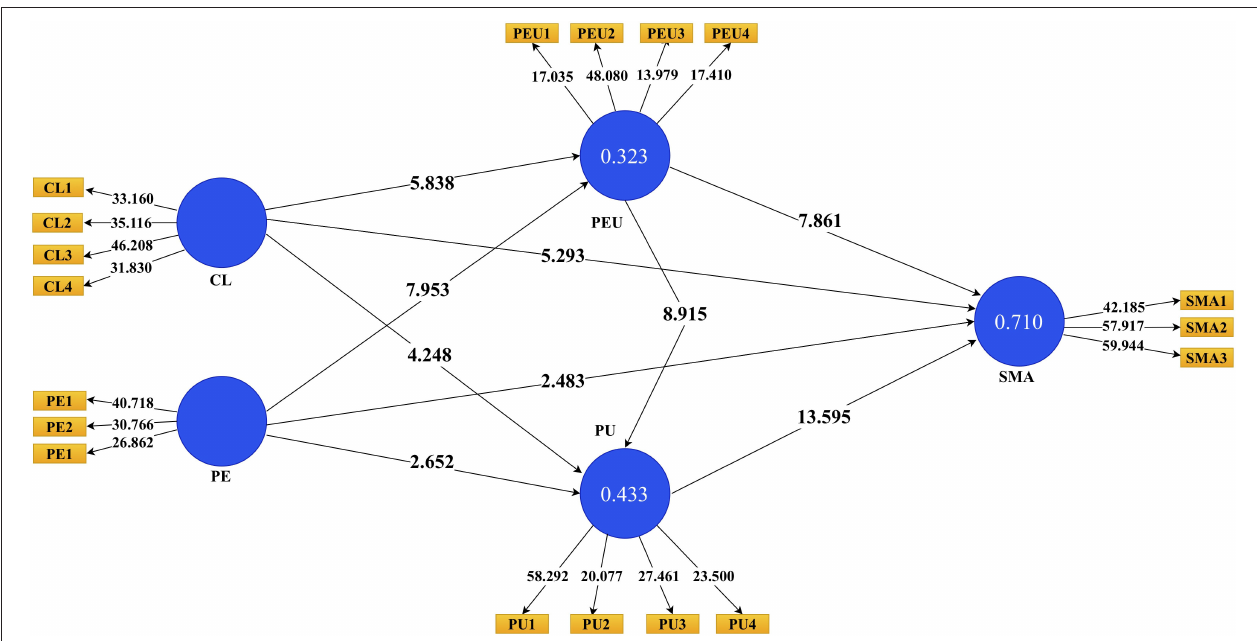
FIGURE 3 | Bootstrapping path coefficient results.